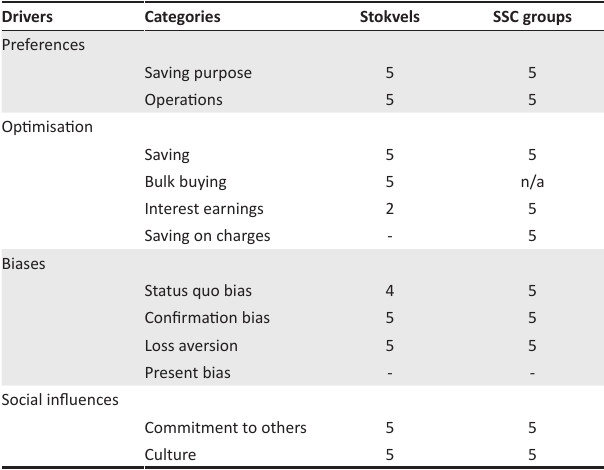
FIGURE 2: Overview of results: Research question TABLE 2: Overview of drivers of saving behaviour.